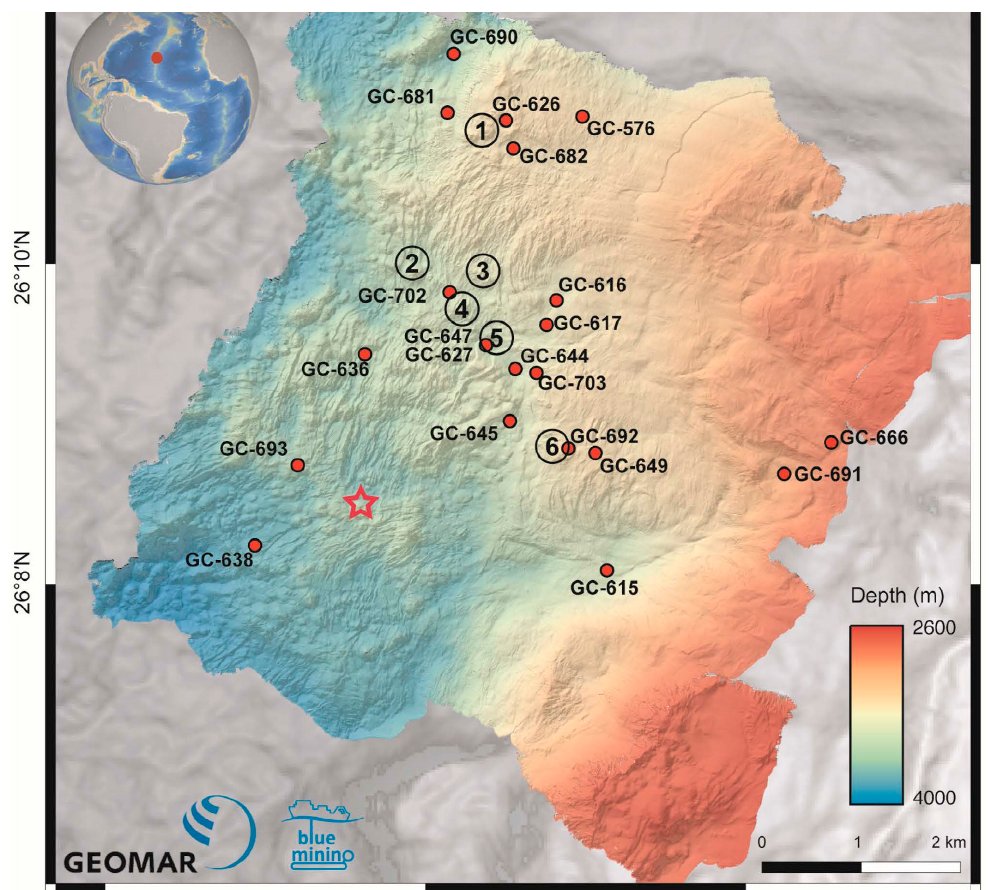
Figure 1. Location of gravity cores (GCs) recovered during M127 at the TAG hydrothermal field. Autonomous underwater vehicle (AUV) bathymetry map (2 m resolution) produced by GEOMAR (Helmholtz-Center for Ocean Research, Kiel, Germany) [14]. 1—Shimmering mound; 2—Shinkai mound; 3—Double mound 4—Southern mound; 5—Central area; 6—MIR zone; Red star-TAG active mound.